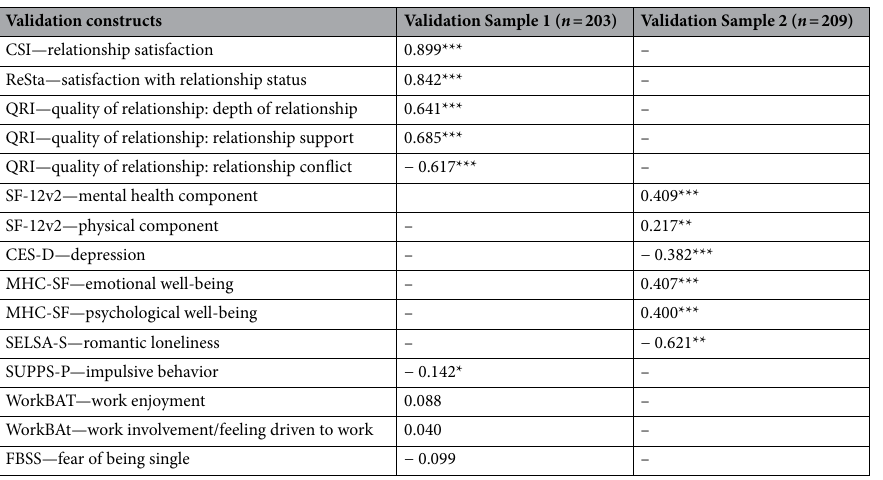
Table 6. Convergent and divergent validity of the Polish Relationship Assessment Scale. Numbers represent correlations. CSI Couples Satisfaction Index, ReSta Relationship Satisfaction Status Scale, QRI Quality of Relationships Inventory, SF-12v2 SF-12v2 ® Health Survey, CES-D The Center for Epidemiologic Studies Depression Scale, MHC-SF Mental Health Continuum-Short Form, SELSA-S Social and Emotional Loneliness Scale for Adults-Short Form, SUPPS-P The Impulsive Behavior Scale Short Version, WorkBAT Workaholism Battery, FBSS Fear of Being Single Scale. * p < 0.05, ** p < 0.01, *** p <